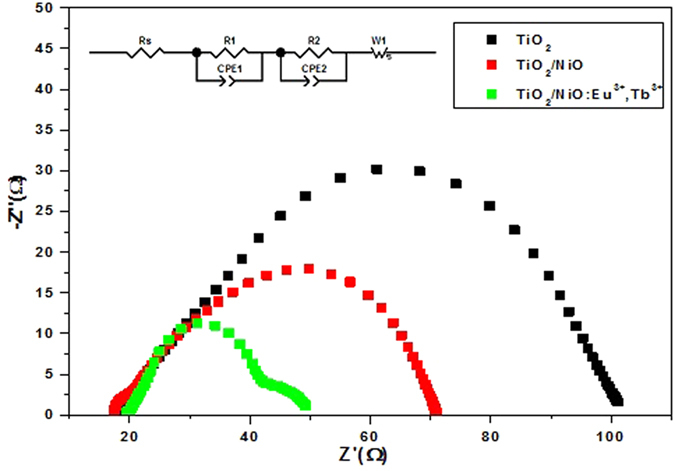
Impedance spectra of the devices with TiO2, TiO2/NiO and TiO2/NiO:Eu3+,Tb3+ under illumination.